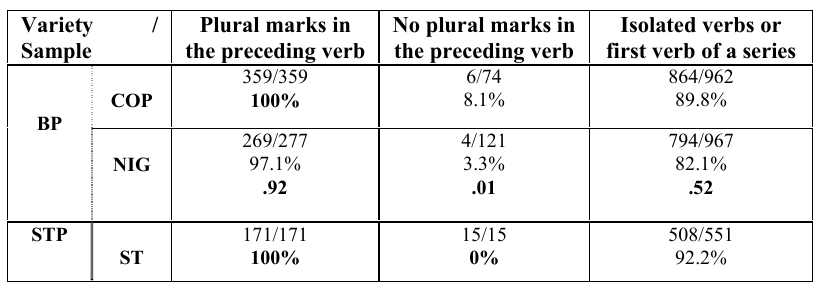
Table XVII: Third person plural verbal